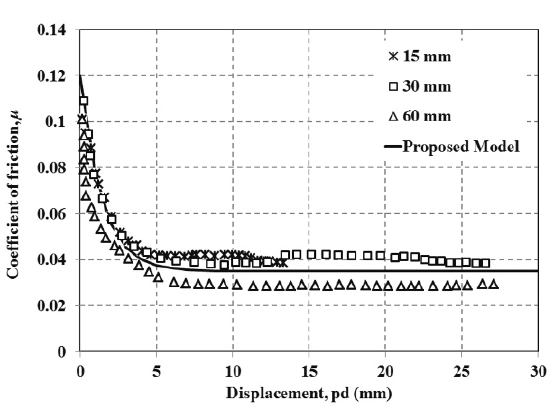
Figure 4. Coefficient of friction versus pullout displacement curves for smooth fiber and normal strength SCC.